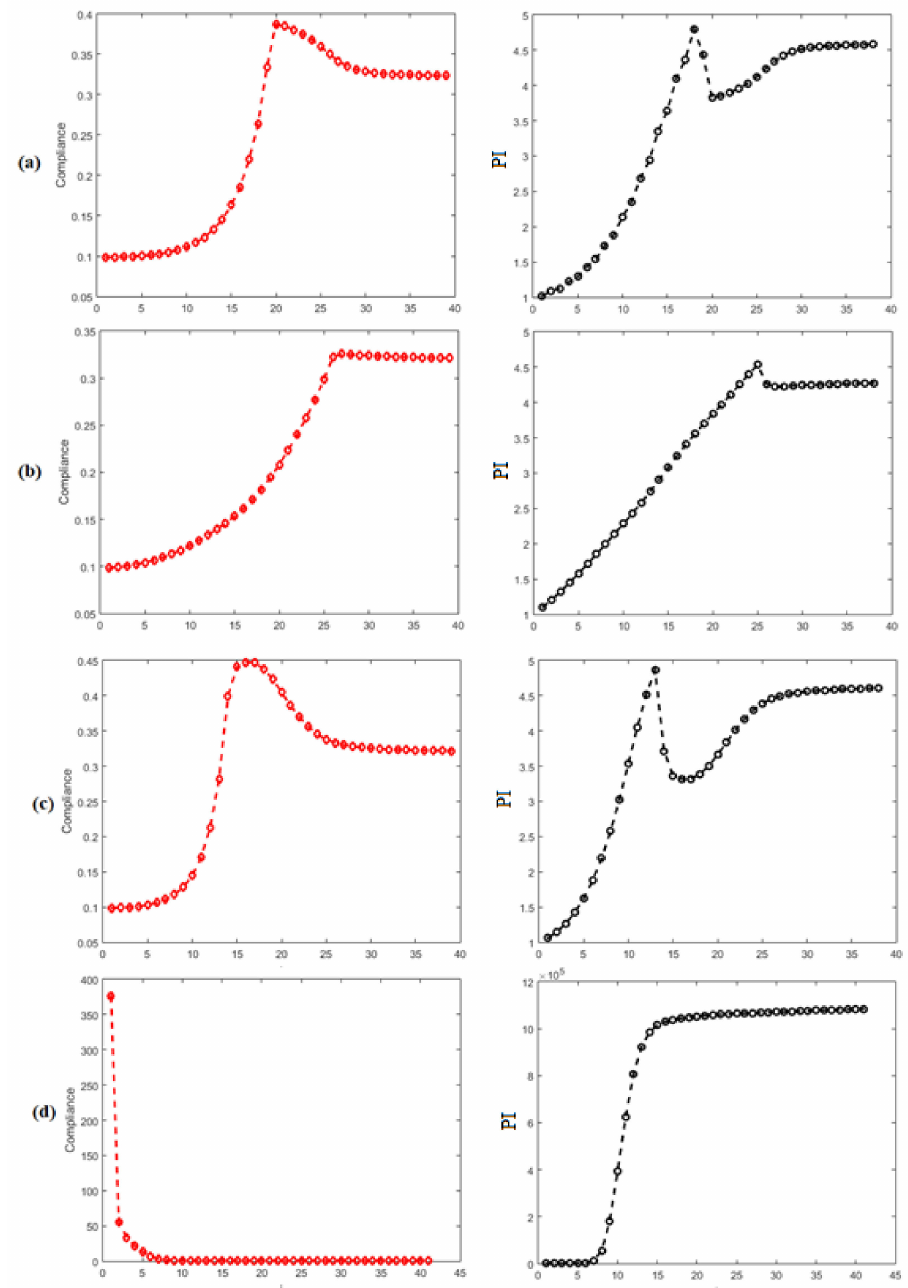
Figure 7. Objective function and performance index (PI): ( a ) ESO, ( b ) SERA, ( c ) SESO and ( d )